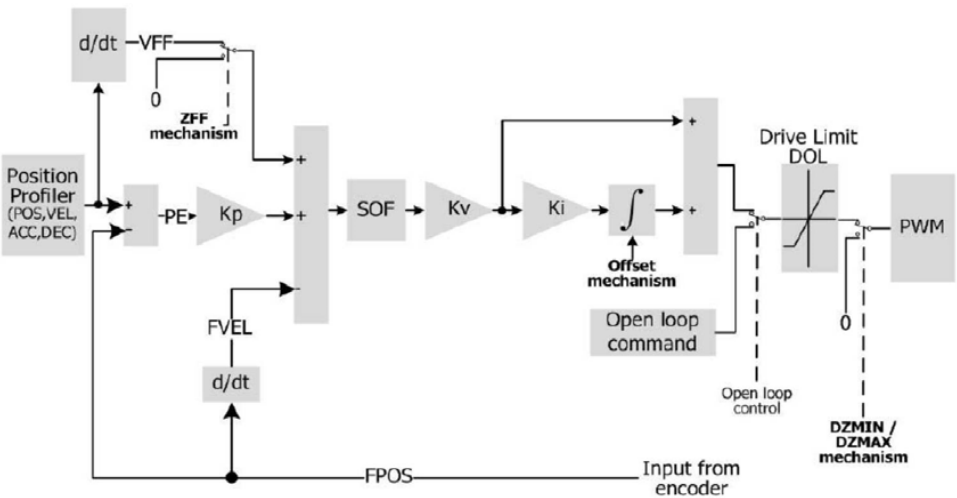
Figure 6. Motion controller servo loop block diagram (Nanomotion XCD controller [18]).